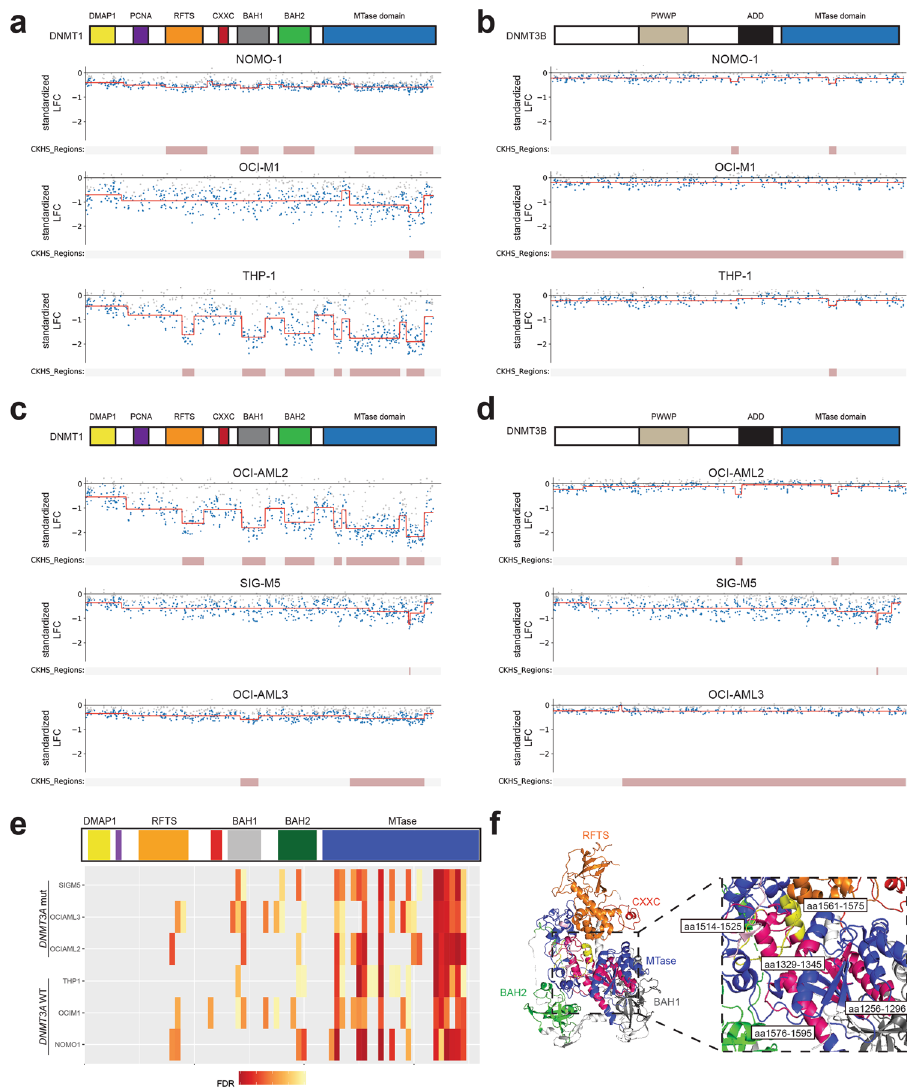
Fig. 5 Mutations in the catalytic MTase domain of DNMT1 affect proliferation in AML cell lines. a , b The CKHS pro fi le (from ProTiler) of DNMT1 ( a ) and DNMT3B ( b ) in DNMT3A wild-type cell lines NOMO-1, OCI-M1, and THP-1. c , d The CKHS pro fi le of DNMT1 ( c ) and DNMT3B ( d ) in DNMT3A mutant cell lines OCI-AML2, SIG-M5, and OCI-AML3. e STARS analyses on bins of 11 sgRNAs along the span of the DNMT1 protein in SIG-M5, OCI-AML3, OCI- AML2, THP-1, OCI-M1, and NOMO-1 cells. A bin with an FDR of less than 0.25 was considered to have a signi fi cant impact on cell proliferation. The PCNA (purple) and CXXC (red) functional domains are not labeled on the DNMT1 protein structure. f 3D structure of DNMT1 (amino acids 291-1620; PDB ID: 4WXX) with functional domains RFTS (orange), CXXC (red), BAH1 (gray), BAH2 (green), and MTase (blue) domains labeled. The amino acids spanning the sgRNA bins in the MTase domain that gave a STARS FDR < 0.25 are colored in magenta and labeled on the structure with the respective amino acids position(s) that the sgRNAs targeted. The 2 bins that were the most consistent hits across the cell lines screened screens (aa 1514 – 1525 and aa 1561 – 1575) are highlighted in